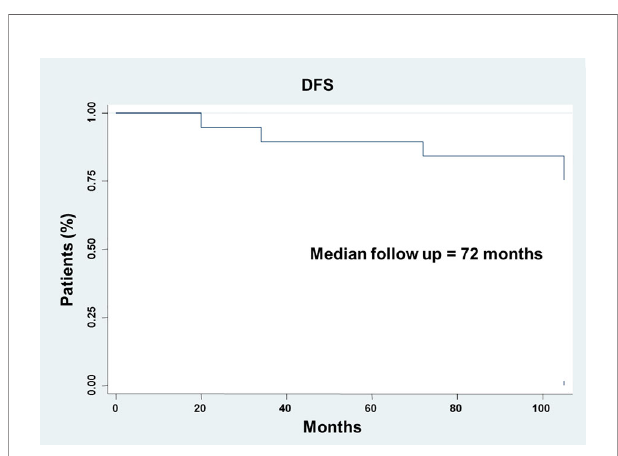
FIGURE 1 | Analysis of the disease-free survival (DFS) in thin melanoma. DFS analysis was analyzed using the Kaplan-Meier